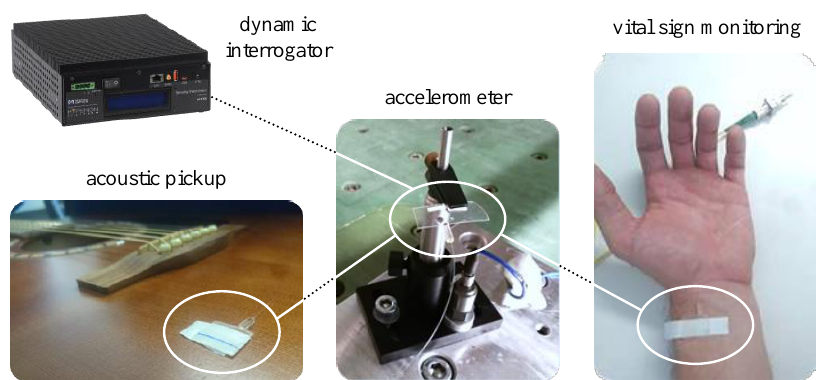
Figure 3. Tested optomechanical application scenarios of the flexible Bragg grating sensor device by the use of a Micron Optics HYPERION si155 dynamic interrogation system providing sensor signal rates up to 1000 Hz.